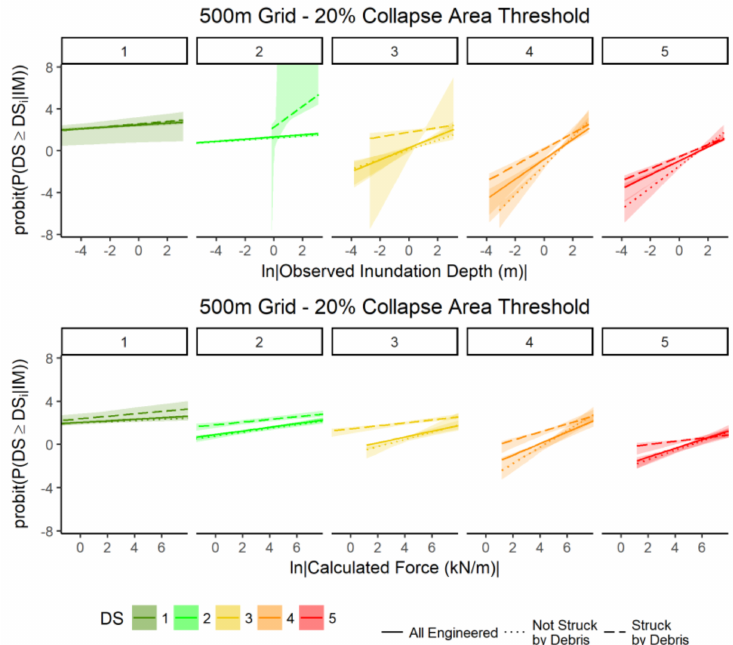
Figure 6. Fragility functions for observed inundation depth ( top ) and simulated force ( bottom ) for fragility functions derived for all engineered buildings (solid line, with 95% bootstrap confidence intervals) and buildings which are/are not deemed to be affected by debris (for the 20% collapse area threshold). Some curve do not extend full the width of fig (e.g., DS2, TIM = h, struck by debris) as for some TIM values there is a cumulative probability of 0, such that probit(0) cannot be evaluated, and so the curve cannot be drawn for these TIM